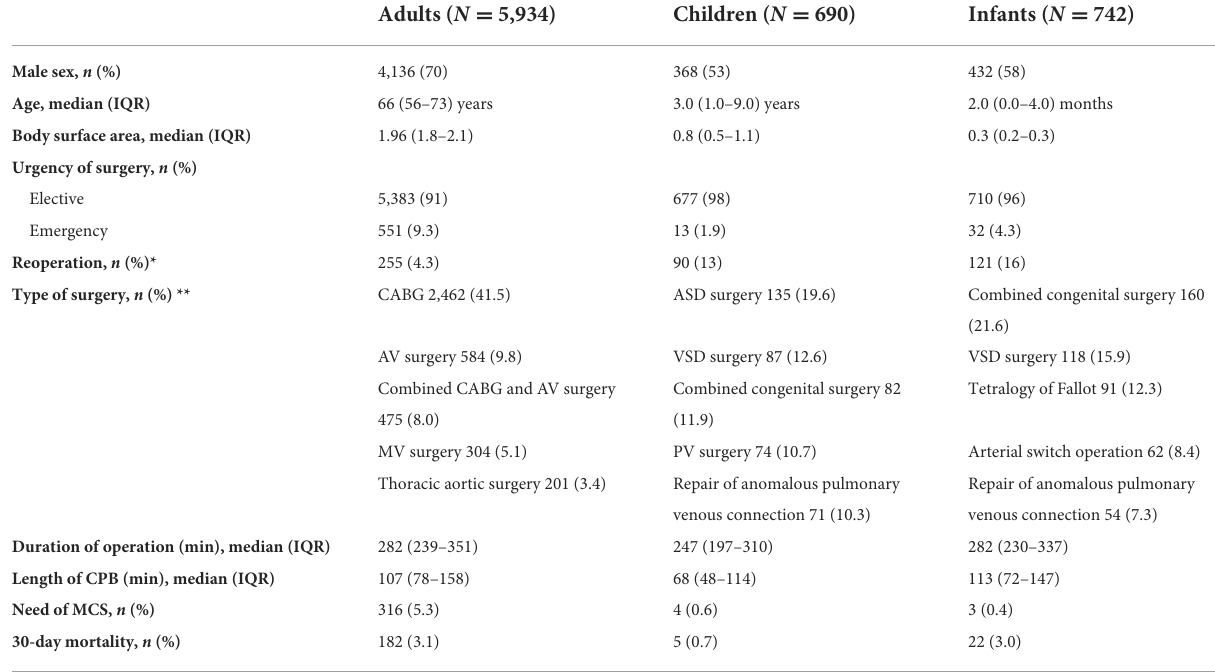
TABLE 2 Patient demographics and baseline